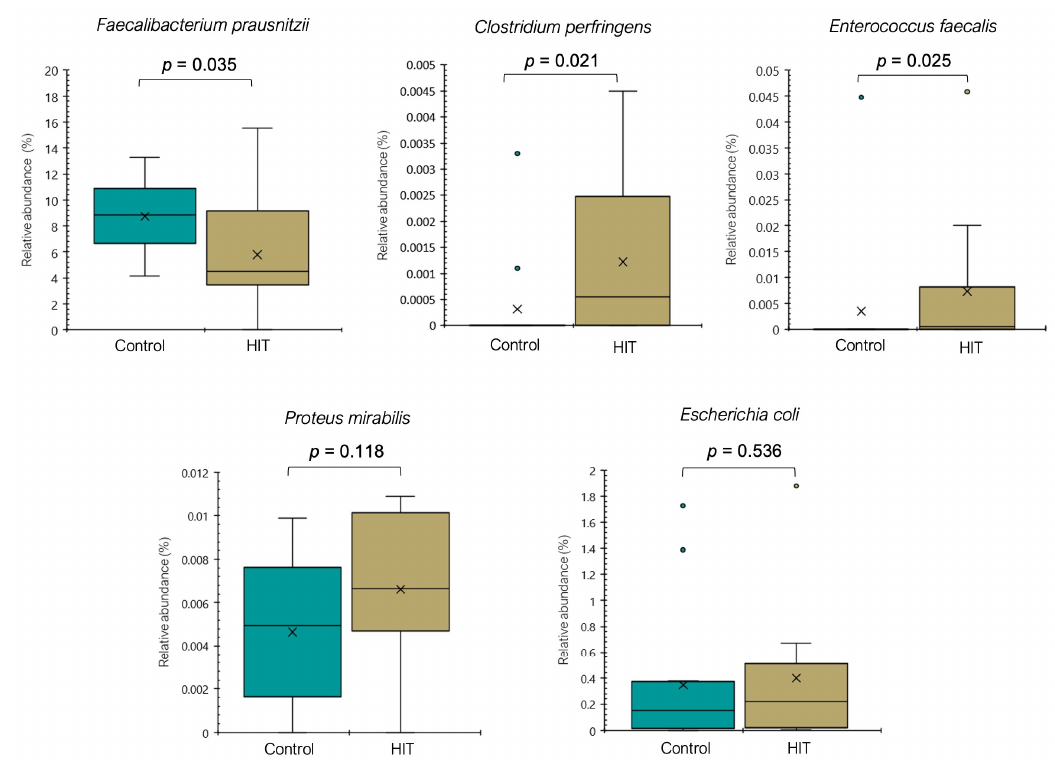
Figure 3. Relative abundance (%) of different species in the control and HIT groups. Mean values are represented with an × and values statistically considered as outliers (atypical values) are plotted as